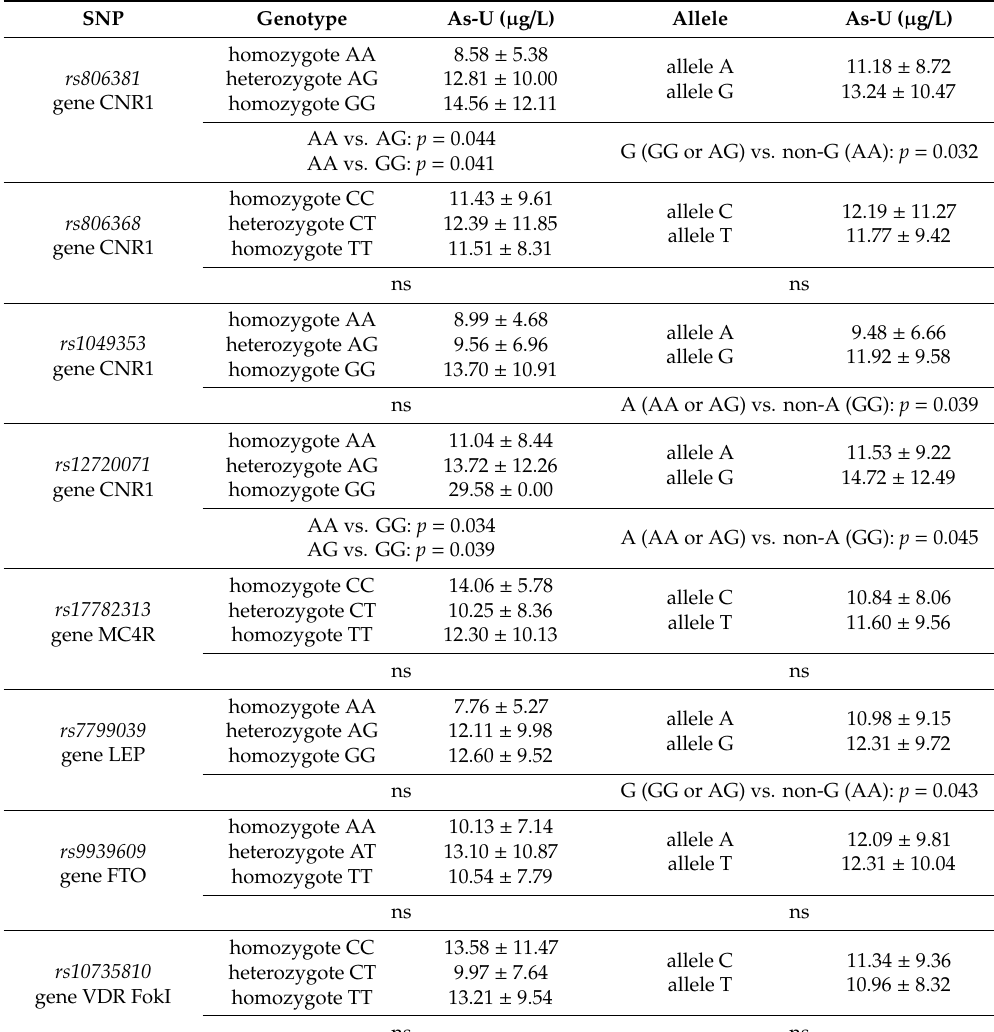
Table 5. Total arsenic concentration in subgroups divided according to selected polymorphisms of genes CNR1, MC4R, LEP, FTO and VDR